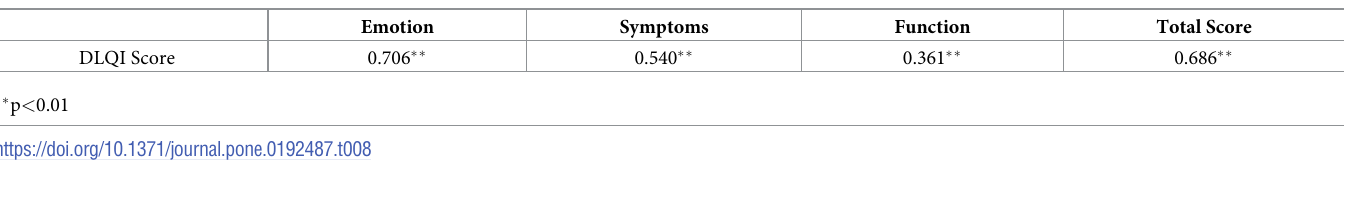
Table 8. Correlation with the DLQI (n =